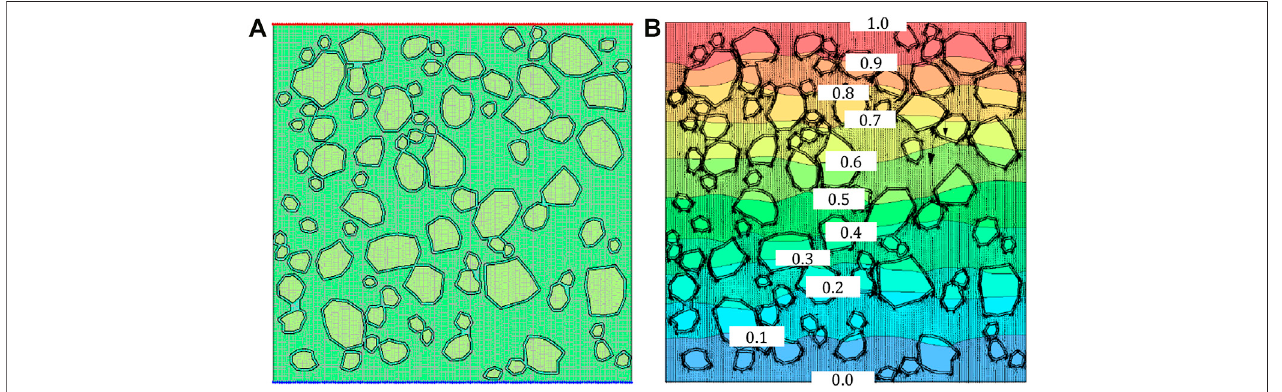
FIGURE 4 | FEM simulation of the three-phase concrete: (A) mesh model and (B) FEM simulation result.